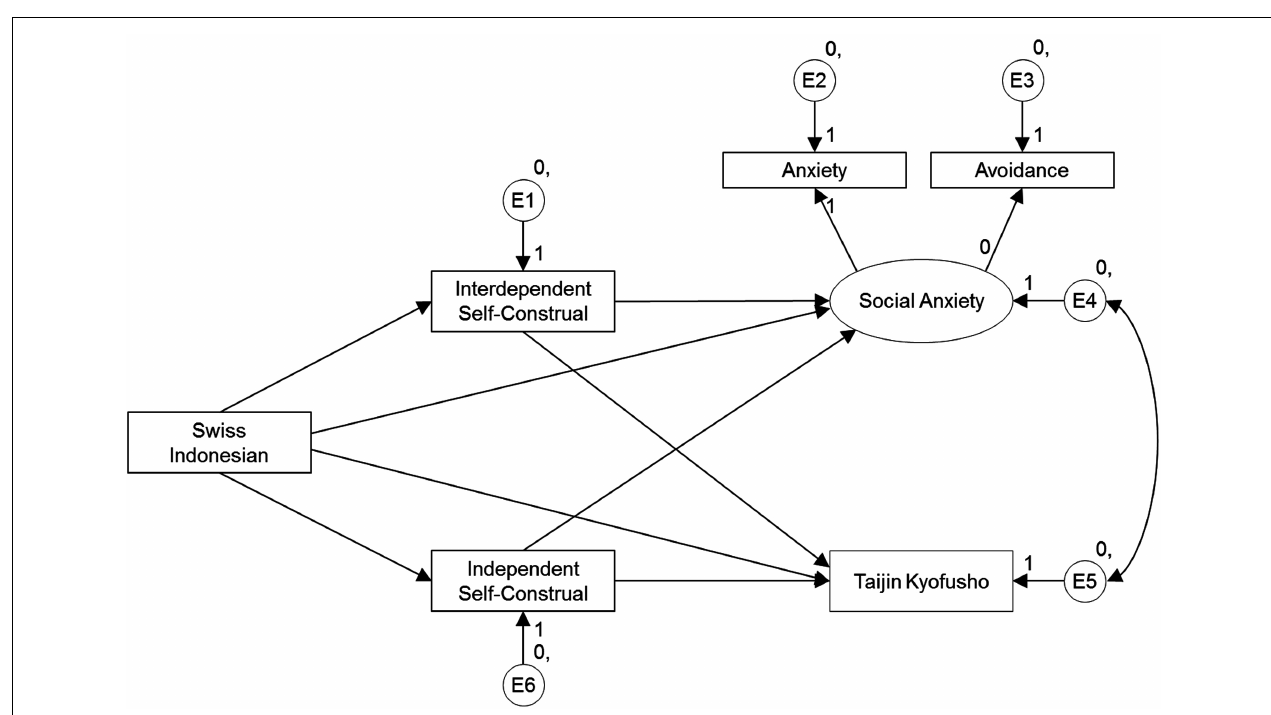
Table 1 | Differences on age, sex, and social anxiety between the Indonesian and Swiss study groups.